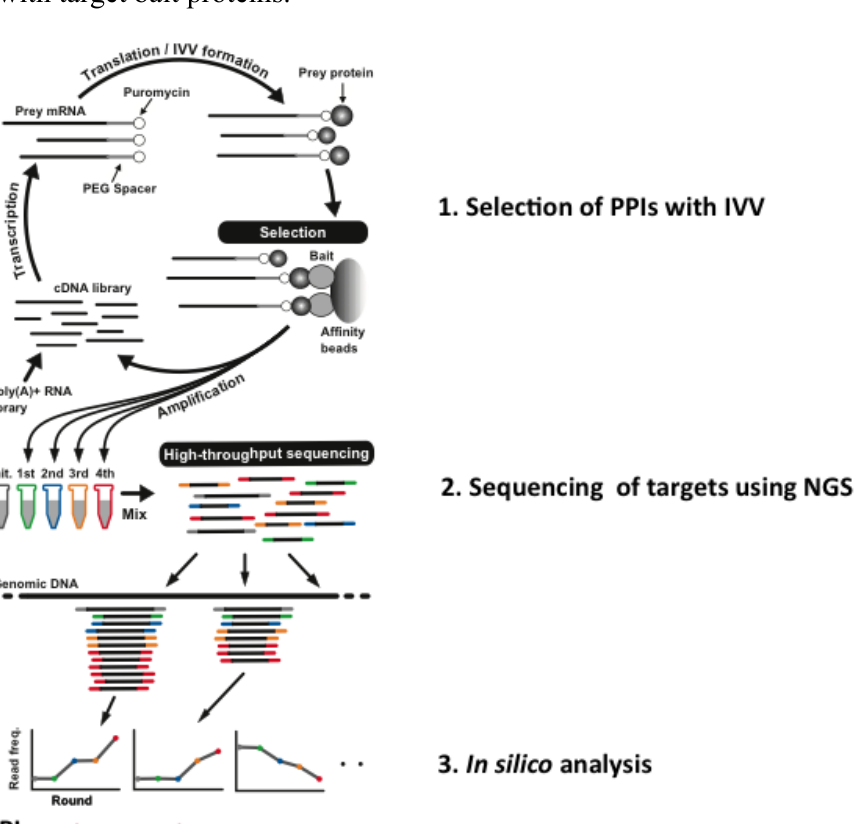
Figure 1. Overview of in vitro virus (IVV)-HiTSeq, a cell-free system for detecting interactors with target bait